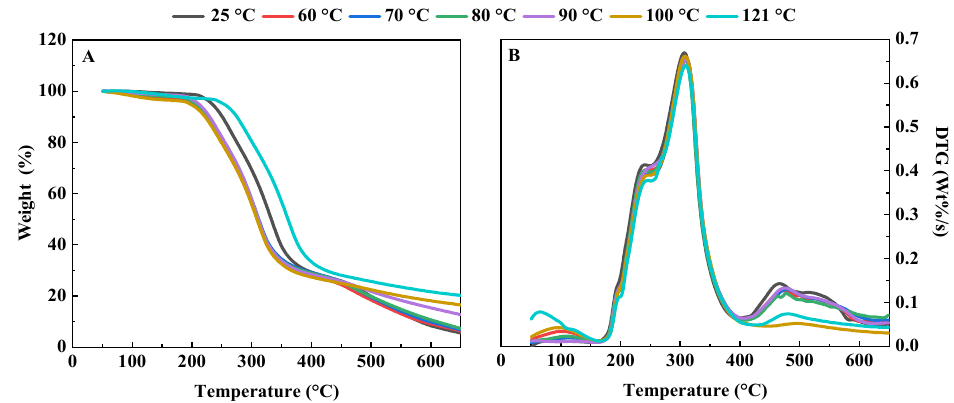
Figure 2. Effects of different hydrothermal treatment temperatures on thermogravimetric ( A ) and derivative thermogravimetric curve ( B ) of QPI.